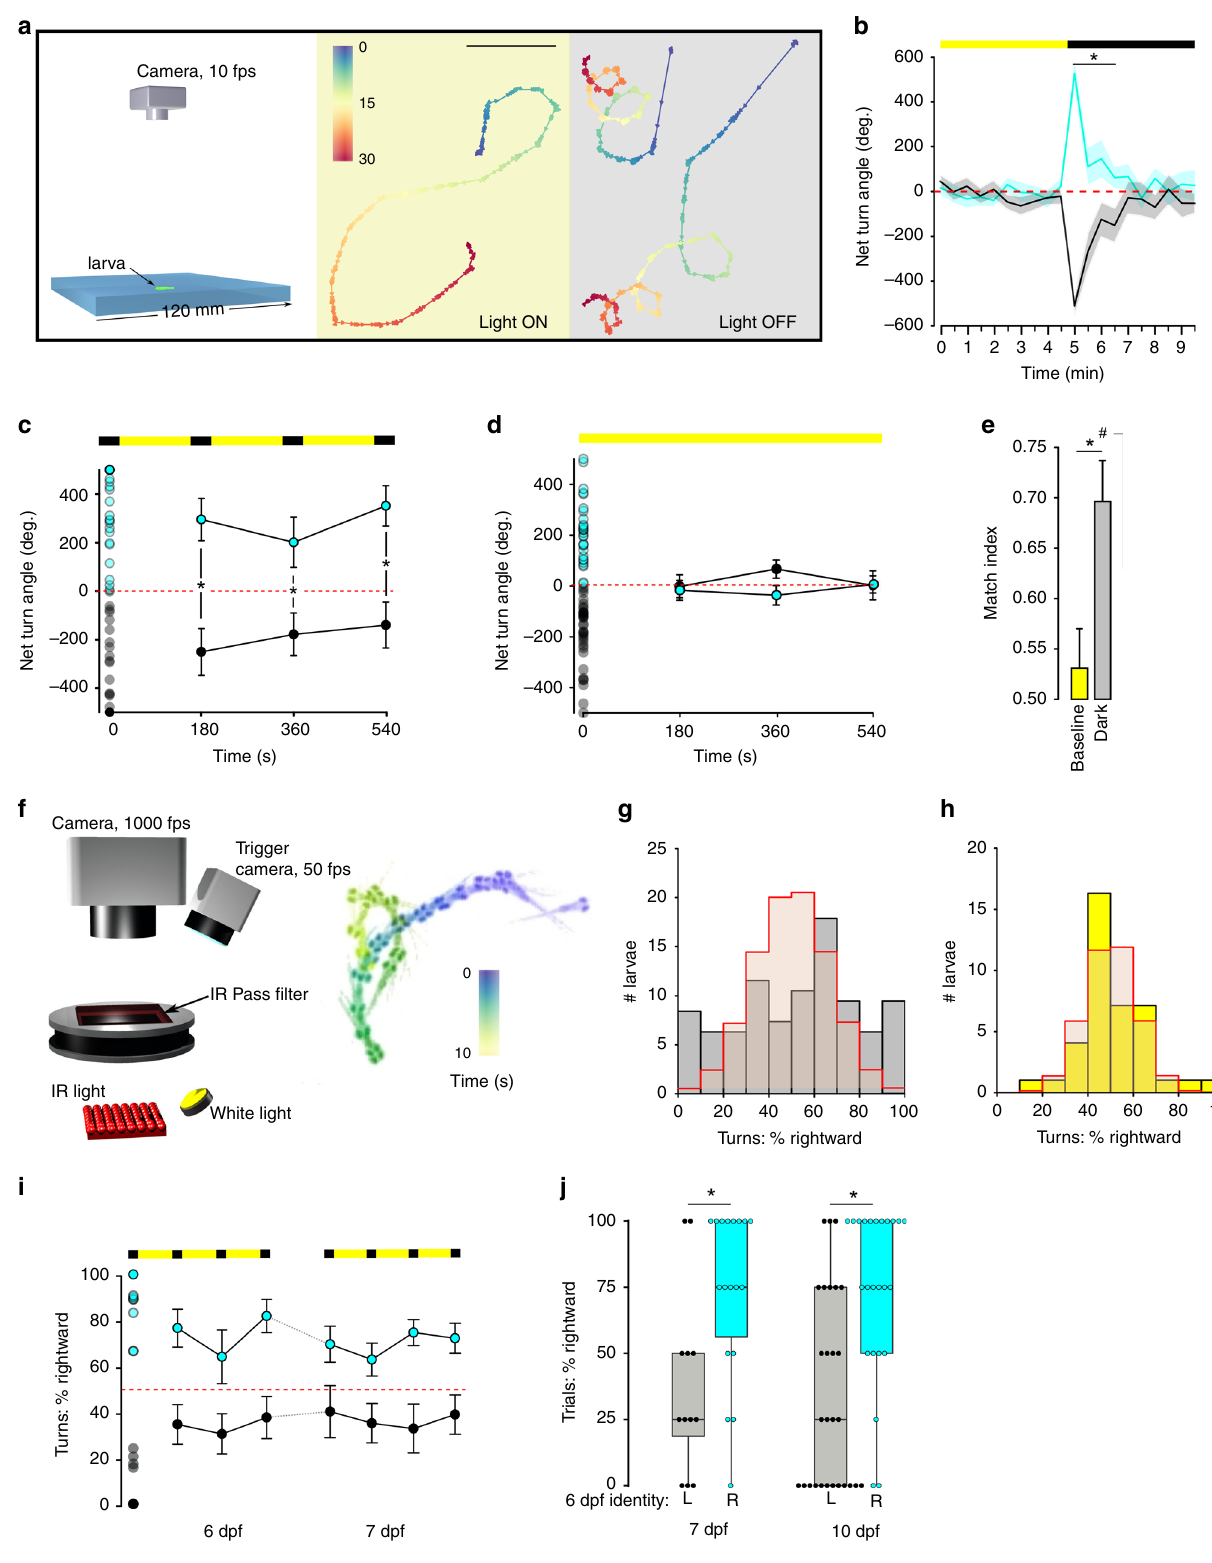
regions 35 . We fi rst classi fi ed larvae as left- or right-biased during dark-induced circular swimming, then used a closed- loop system to present freely swimming larvae with two identical target spots on the left and right after the loss of full- fi eld illumination (Fig. 2a, b). Target choice was positively correlated with circular swimming direction (Fig. 2c). We